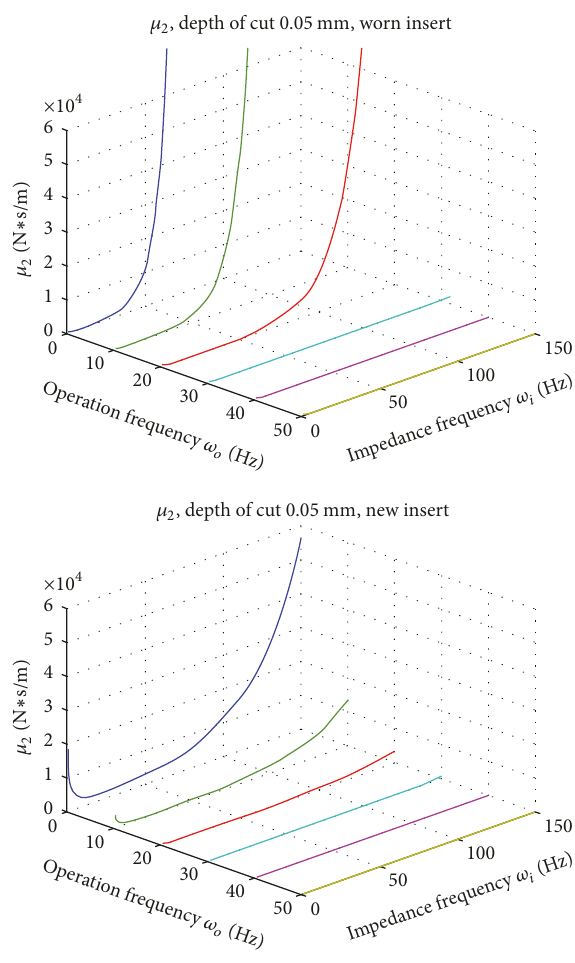
Figure 10: Comparison of 𝜇 2, at 0.05 mm of depth of cut, worn versus new